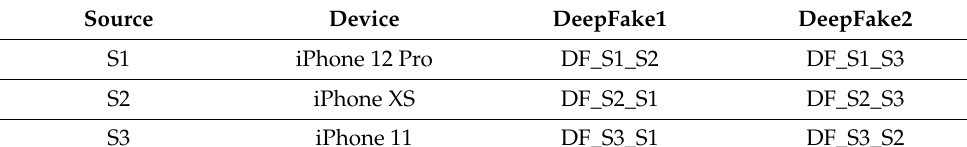
Table 3. Source: name of the devices used for the UntouchedVideo dataset. Device: device model; DeepFake1 and DeepFake2 are the videos generated from the UntouchedVideo dataset. They are obtained by superimposing the face of a selected video ( Destination ) on the face of the original one ( Source ).